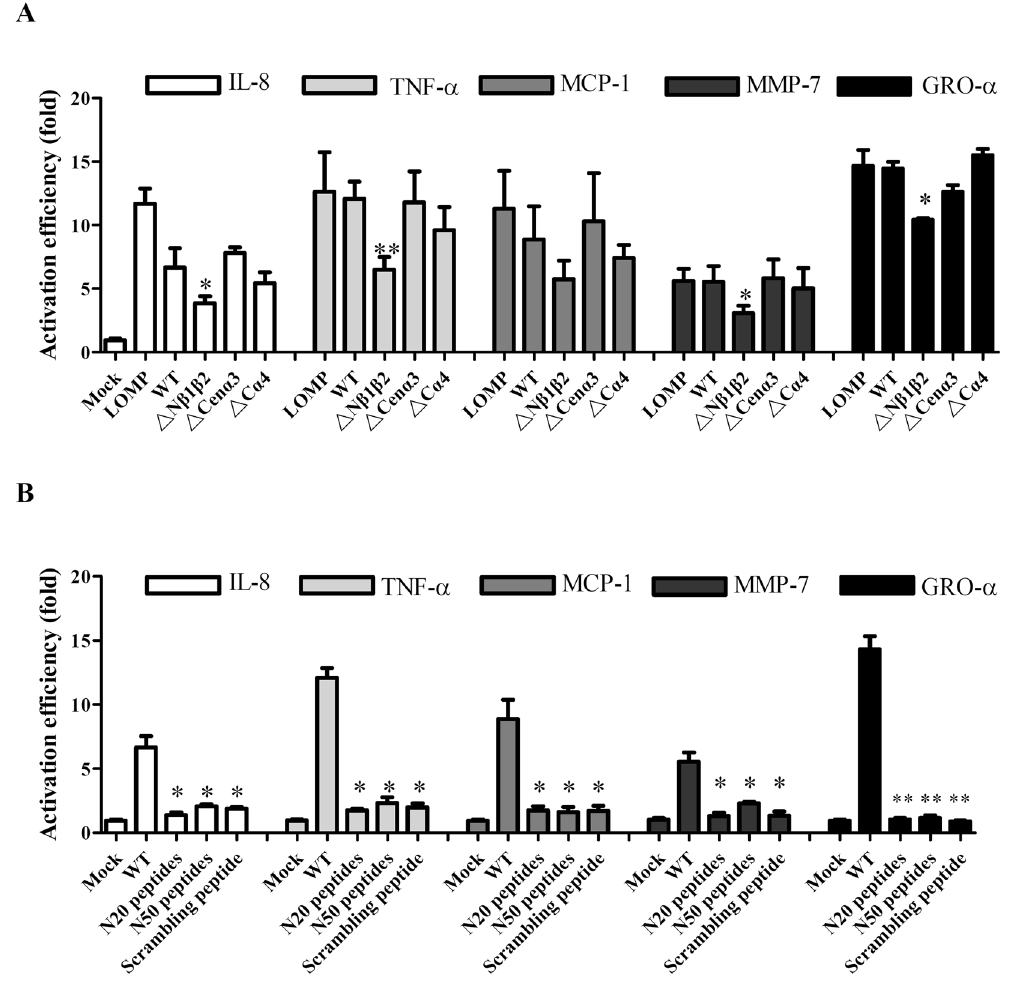
Figure 3. Stimulation of inflammatory responses by LipL32WT and its variants. ( A ) LipL32WT and its variants were used to stimulate the expression of IL-8 (white bar), TNF- α (light gray bar), MCP-1 (gray bar), MMP7 (dark gray bar), and GRO- α (black bar) on HEK293-TLR2 cell. LOMP, Leptospira outer membrane protein extraction; WT, wild-type LipL32 protein; Δ N β 1 β 2, deletion of β 1 β 2 domains of LipL32; Δ Cen α 3, deletion of central α 3 domain of LipL32; Δ C α 4, deletion of C-terminal α 4 domain of LipL32. ( B ) The synthesized peptides were used to stimulate the expression of IL-8 (white bar), TNF- α (light gray bar), MCP-1 (gray bar), MMP7 (dark gray bar), and GRO- α (black bar) on HEK293-TLR2 cell. N20 peptide (1–20 residues of LipL32); N50 peptide (1–50 residues of LipL32); C25 peptide (248–272 residues of LipL32), and a scrambling peptide with the sequence of VSLEGLTKVLAGSKFSESPILIKTVCDMILGASFANPALKISTASTLFTG. * p < 0.05; ** p <